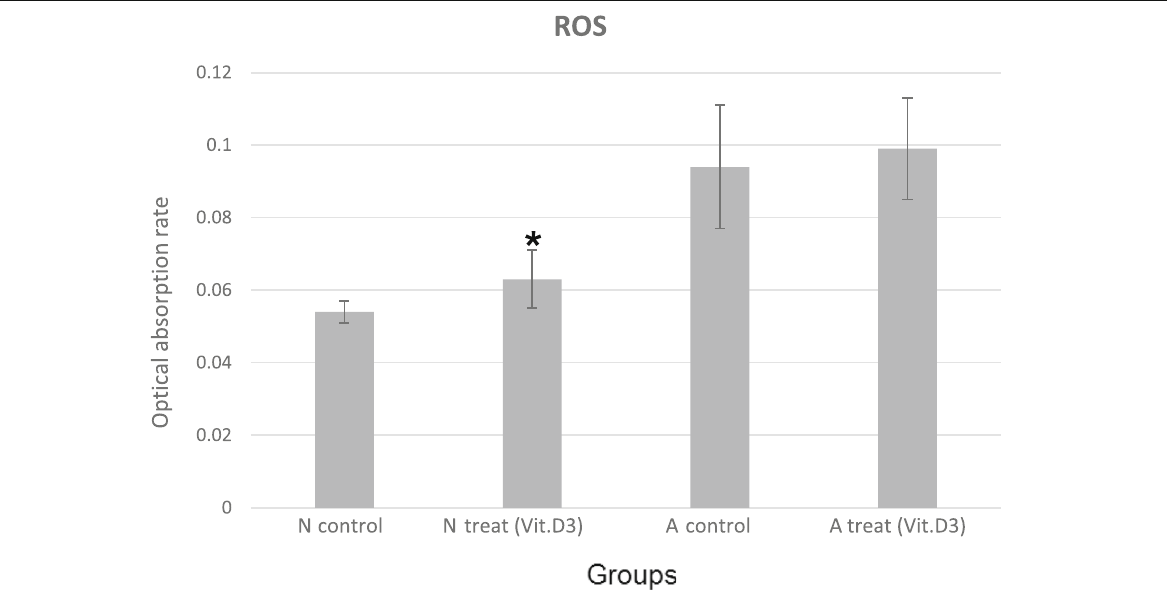
Fig. 5 Effects of Vit.D3 on intracellular ROS in normal (N) and asthenozoosperm (A) samples. The values are expressed as means of optical absorption rate. *Significant difference as compared to the control group [CI = 0.0025 –